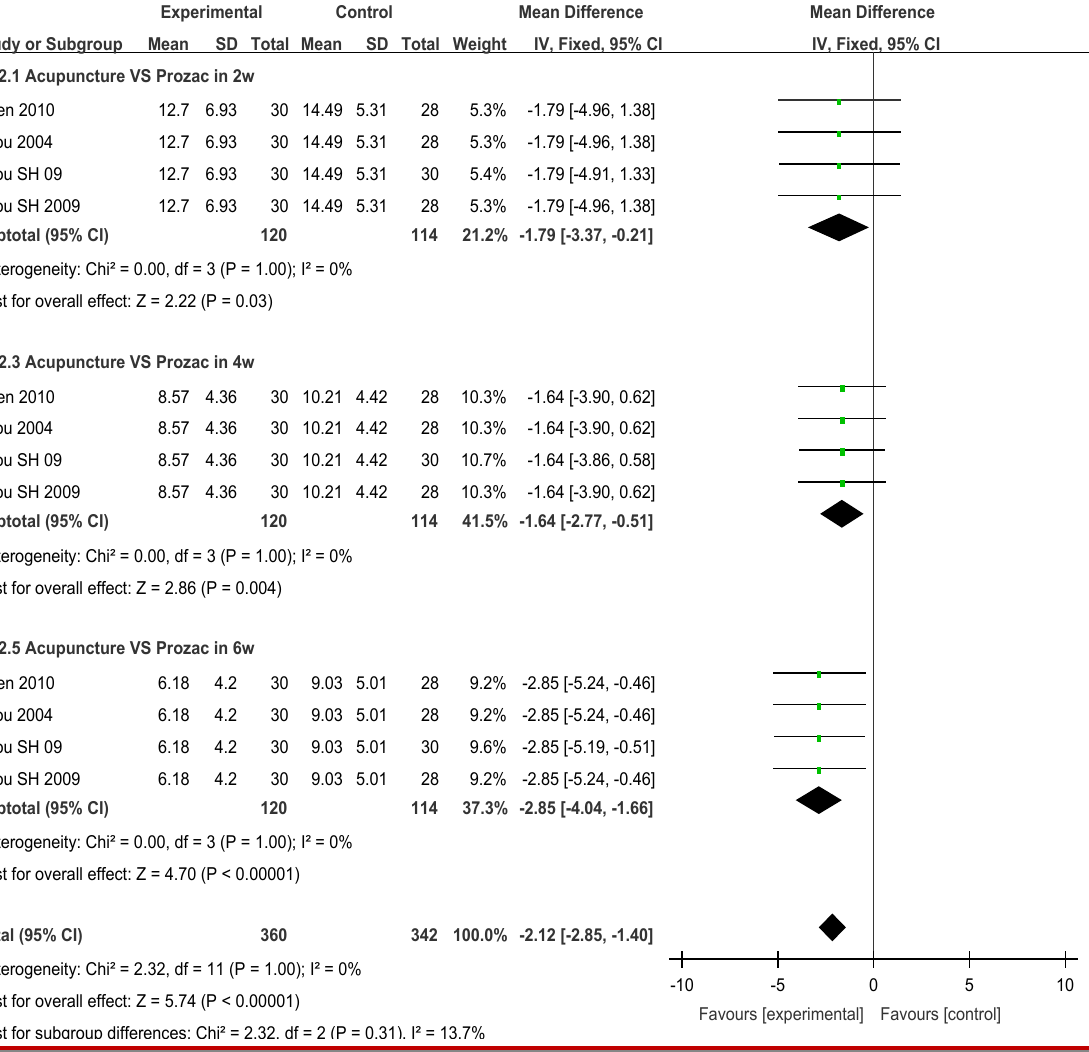
Figure 6: Meta-analysis of the studies evaluating HAMA scores of